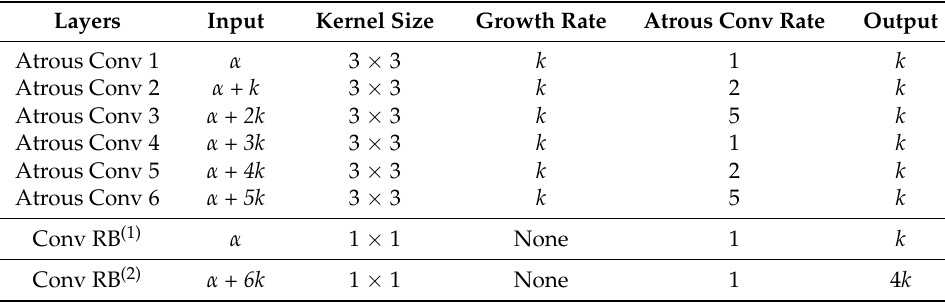
Table 1. Dense atrous convolution block structure Figure 3. Dense atrous convolution blocks for JointNet.